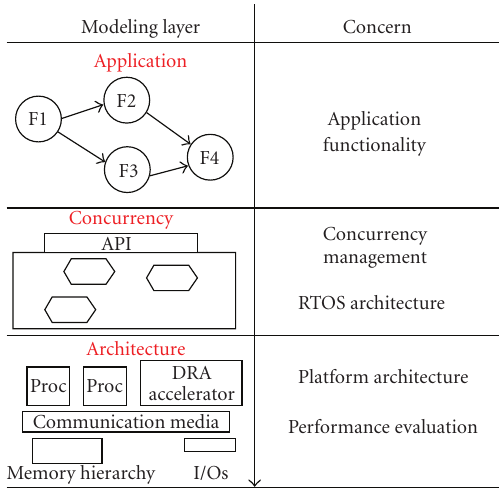
Figure 2: Our modeling approach follows the separation of con- cerns paradigm. The Application layer is a set of pure C functions and focuses on the functional specification of the algorithms. The Concurrency layer is a set of RTOS services and focuses on the distribution of these services. This layer also brings concurrency between threads according to the type of the associated PE. The Architecture layer is a set of parametrizable PEs, CEs and memories and represents the embedded platform. This layer also brings accurate timing